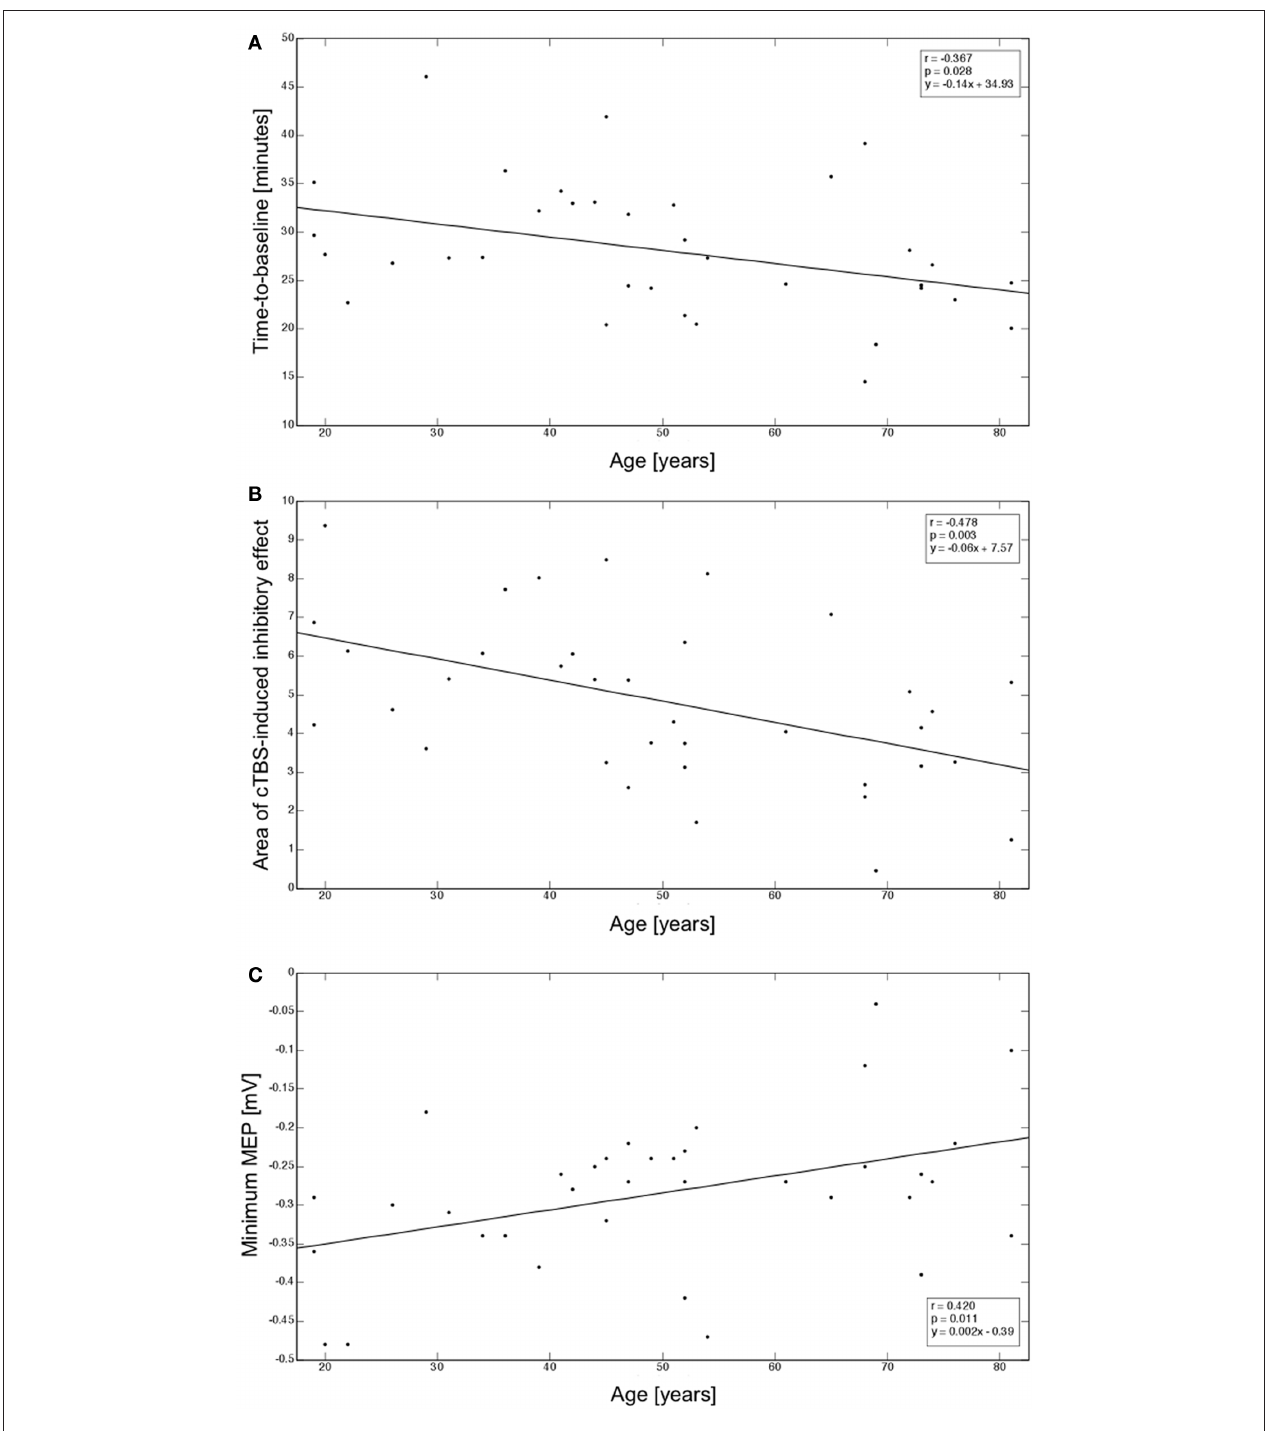
Figure 2 | (A) Correlation between age and time-to-baseline; (B) Correlation between age and area of inhibitory effects after cTBS; (C) Correlation between age and minimum MEP amplitude reached after cTBS. Correlation coefficients ( r ), corresponding regression slopes, and intercept values are indicated (box).